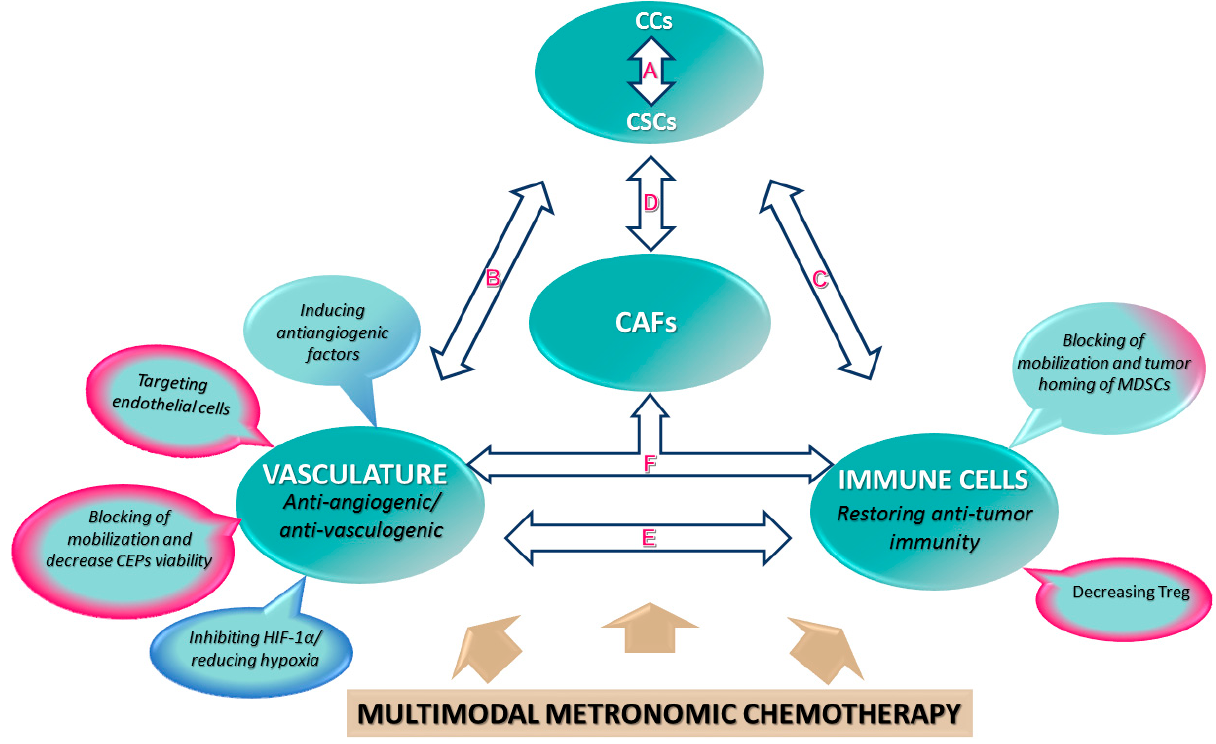
Figure 1. General biological mechanisms of action of MC to explain their antitumor effects. Links that create a permissive tumor microenvironment and could be affected by metronomic chemotherapy (two-way arrows). The CSC population is characterized by heterogeneity, plasticity, and therapy-resistance [215,216]. The reciprocal interactions between CSCs, cancer cells, endothelial cells, immune cells, CAFs, and other extracellular elements of the tumor microenvironment regulate CSCs in the primary tumor and metastases [217,218]. ( A – D ): ( A ) A feedback-signaling mechanism occurs between cancer cells (CCs) and CSCs. CSCs can induce the conversion of non-stem cells into metastatic-CSCs with a migratory phenotype [219]. Hypoxia/HIF-1 α promotes epithelial-to-mesenchymal transition in cancer cells and maintains stemness [220]. ( B ) CSCs are drivers of vascularization, and the perivascular area constitutes a supportive niche. ( C ) CSCs maintain populations of immunosuppressive cells (e.g., MDSCs, Treg), and tumor-associated MDSCs, in turn, are key components of CSC niches and are essential for the formation of the pre-metastatic niche. ( D ) CSCs induce the transformation of normal stromal fibroblasts into CAFs, which maintains the proliferation and self-renewal of CSCs. Bidirectional link between vasculature and immune cells: ( E ) Tumor-recruited MDSCs are pro-angiogenic and can be transdifferentiated into endothelial-like cells. Tumor MDSCs are immunosuppressive by inhibiting tumor T-lymphocytes and NK cell activation and by inducing immunosuppressive Treg which, in turn, can promote tumor angiogenesis. Cross-talk between CAFs and the vasculature and immune system: ( F ) CAFs contribute to tumor angiogenesis and promote tumor CEP mobilization and recruitment. In turn, tumor endothelial cells can undergo an endothelial-to-mesenchymal transition to CAFs. In addition, CAFs mediate tumor immunosuppression by promoting MDSC recruitment and attracting T-lymphocytes and their differentiation into immunosuppressive Treg. This figure is based on previous studies [20,28]. See Section 3 for more detailed information. Table 1. Summaries of selected preclinical and clinical studies indicating biological mechanism of action of metronomic Reprinted with permission from the original with modifications Ref. [29], Copyright 2021, chemotherapy.